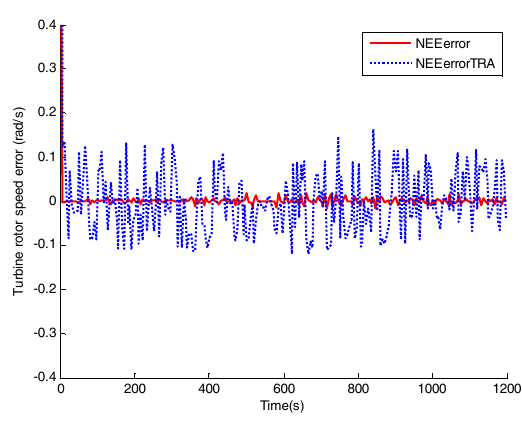
Figure 11. Turbine rotor speed error.